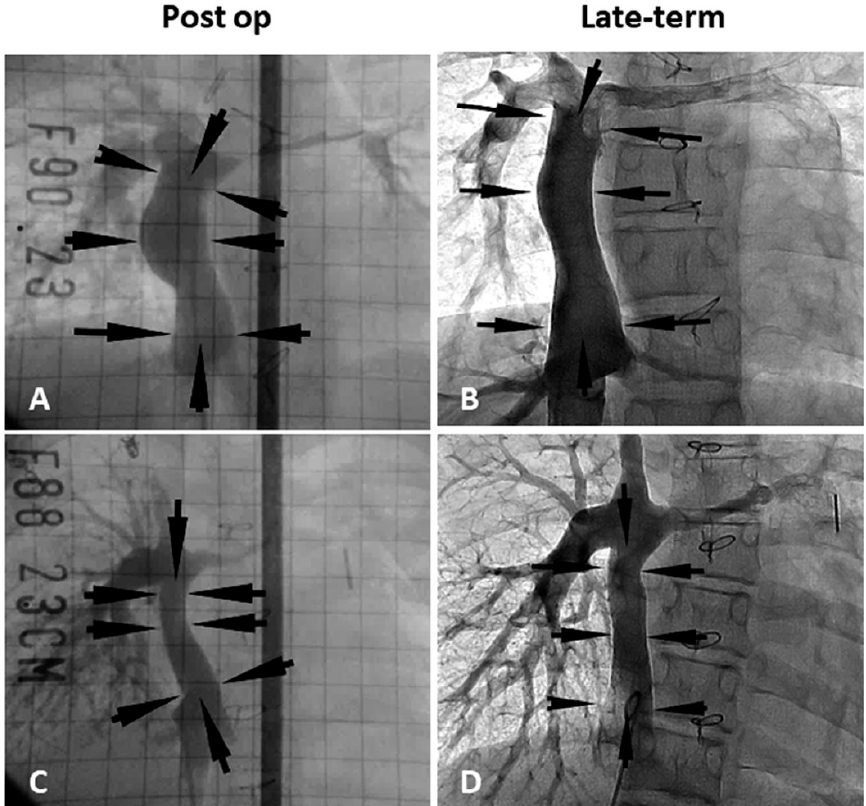
Figure 3. Postoperative and late-term TEVG angiography. ( A ) Postoperative angiography in patient 22. ( B ) Angiography 11 years after implantation in patient 22. ( C ) Postoperative angiography in patient 23. ( D ) Angiography eight years after implantation in patient 23. Arrows indicate the TEVG location. Angiography shows macroscopic growth of the TEVGs. Adopted with permission from Shinoka et al.